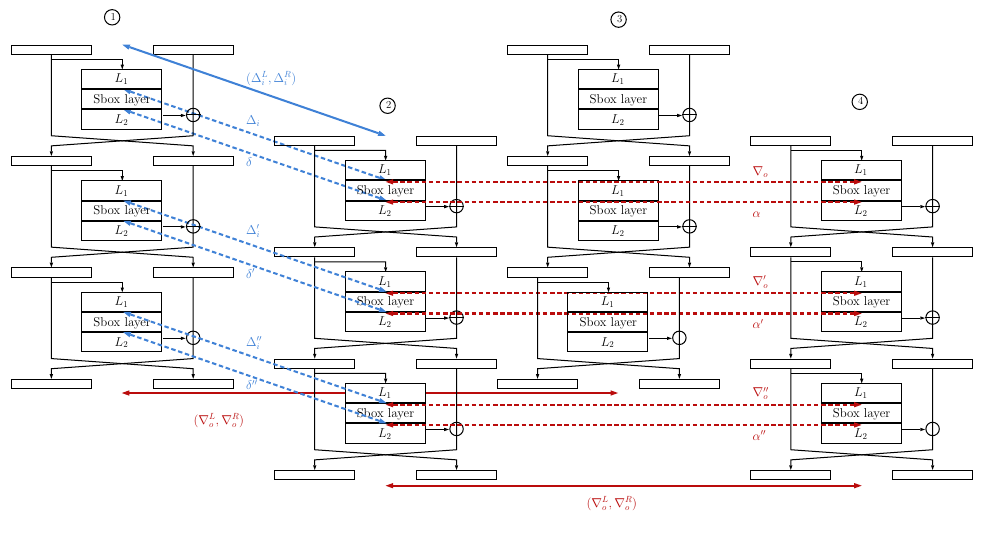
Figure 8: Setting for a boomerang Switch over more than two rounds of a balanced Feistel with two branches. The differences denoted with straight lines are imposed and